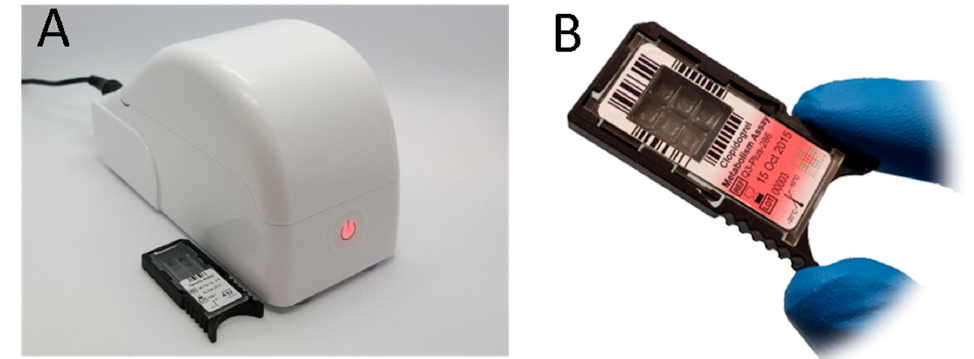
Figure 11. ( A ) The Q3 portable instrument closed, with its LOC cartridge next to it. ( B ) Front view of the Q3 LOC cartridge. Six reaction wells are visible—built over a silicon die—where six independent qPCR reactions